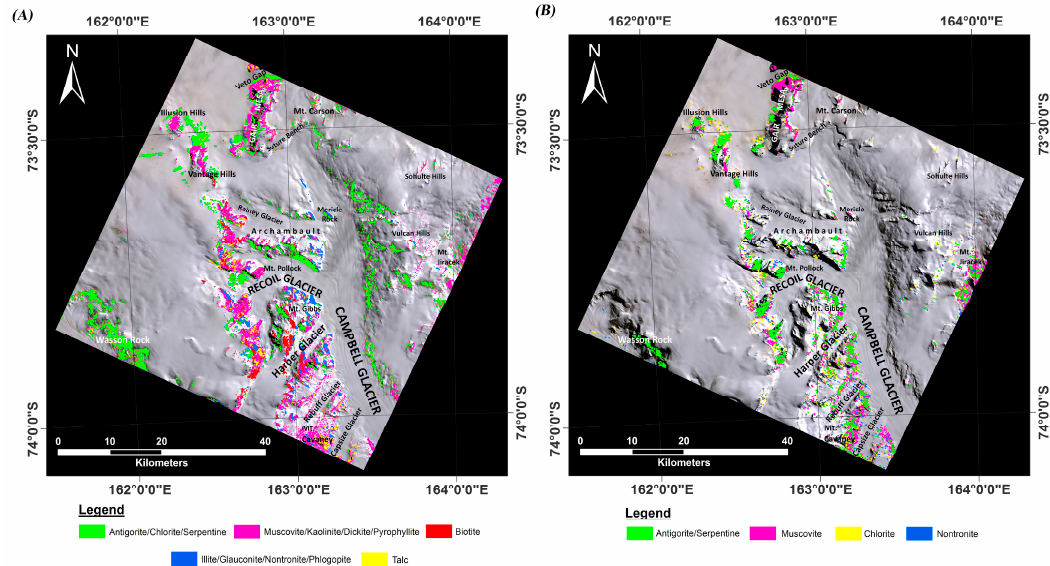
Figure 10. ( A ) CEM classification mineral map for the Campbell Glacier (I) scene derived from fraction images of the selected endmember minerals using ASTER VINR+SWIR bands. ( B ) CEM classification mineral map for the Campbell Glacier (I) scene derived from fraction images of the selected endmember minerals using ASTER TIR